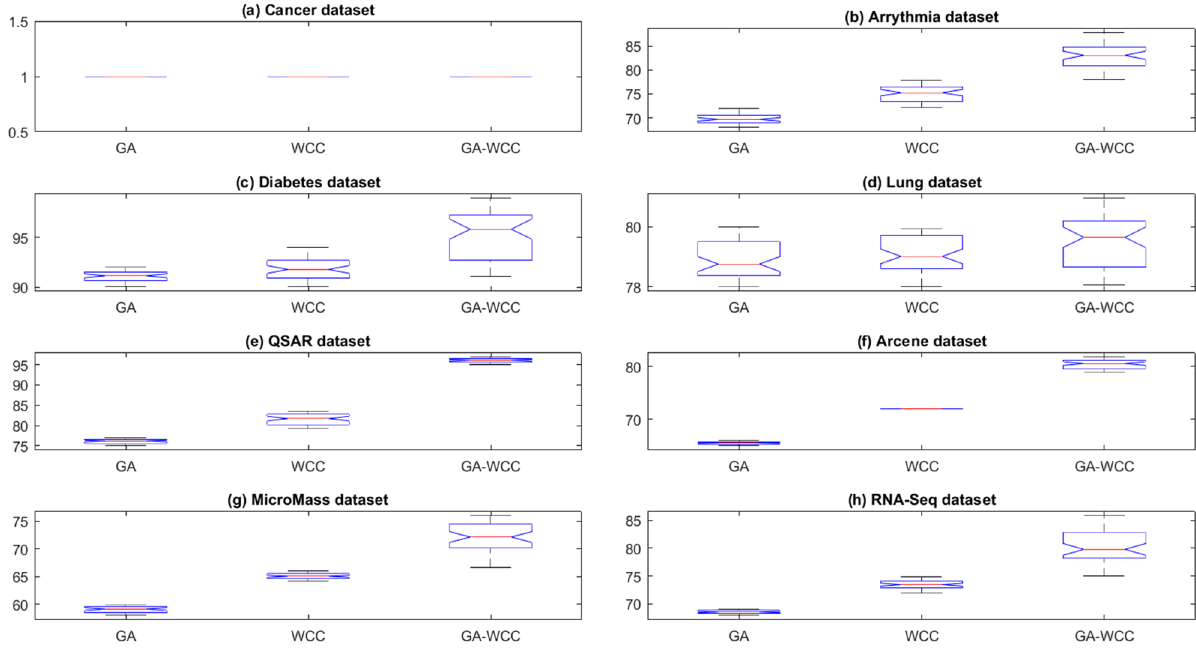
Figure 12. Boxplot of the GA, WCC, GA_WCC algorithms on the ( a ) Cancer, ( b ) Arrythmia, ( c ) Diabetes, ( d ) Lung, ( e ) QSAR, ( f ) Arcene, ( g ) MicroMass, and ( h ) RNA-Seq datasets. For the Cancer dataset, all the algorithms have shown an identical performance. For the remaining ones, although the error value of the GA and WCC algorithms is lower than the GA_WCC method, the proposed method has outperformed the GA and WCC algorithms in terms of accuracy and other classification criteria. WCC, world competitive contests algorithm; GA, genetic algorithm;